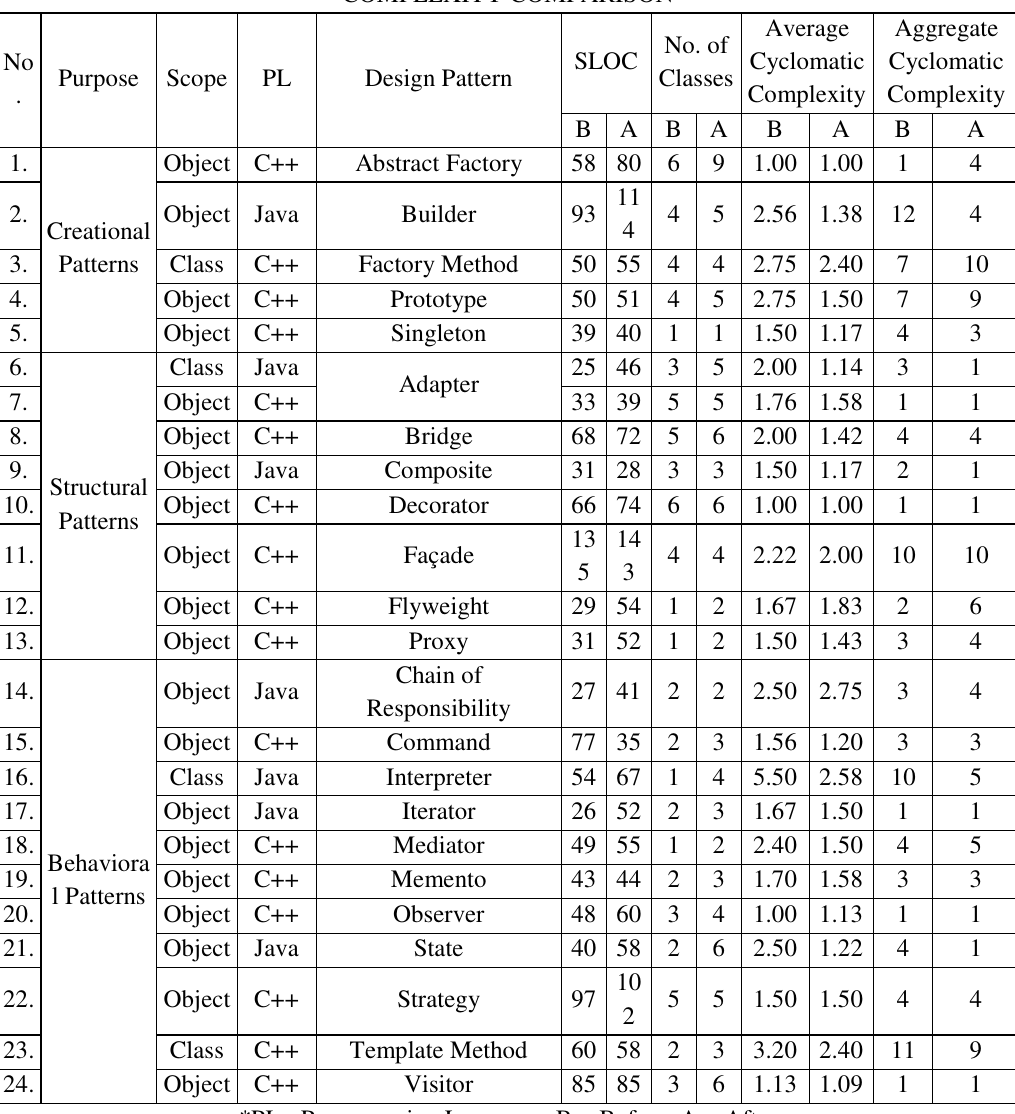
TABLE 3. BEFORE AND AFTER USING DESIGN PATTERNS – SIZE & CYCLOMATIC COMPLEXITY